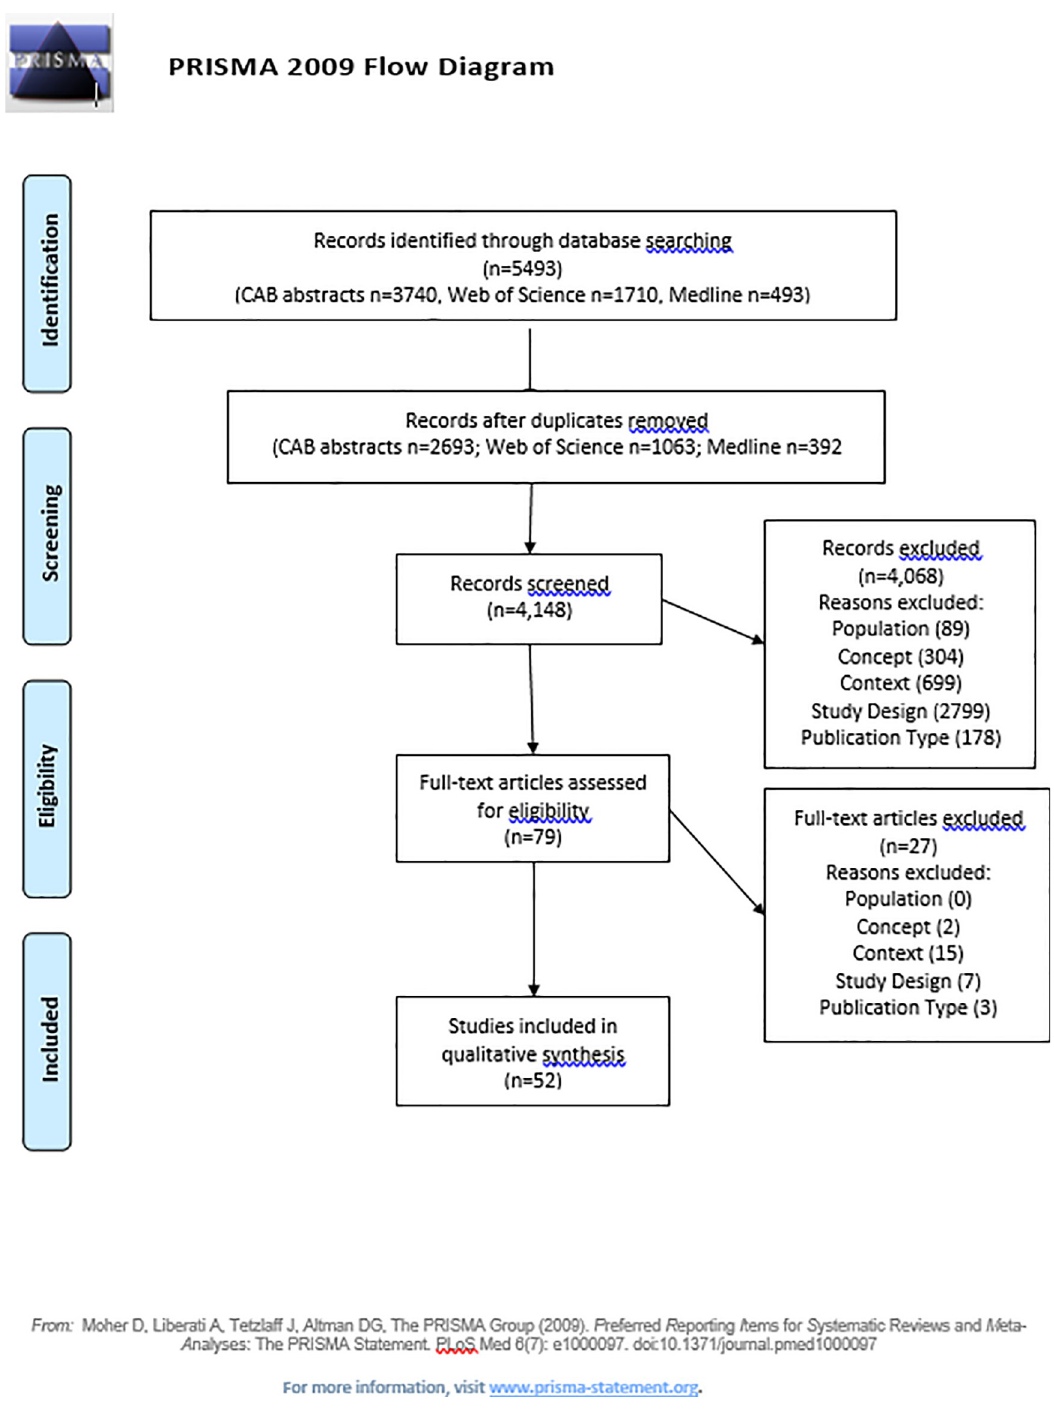
Fig 1. PRISMA 2009 flow diagram for the numbers of studies identified, screened, assessed for eligibility, and included in a scoping review of the risk factors for colic.